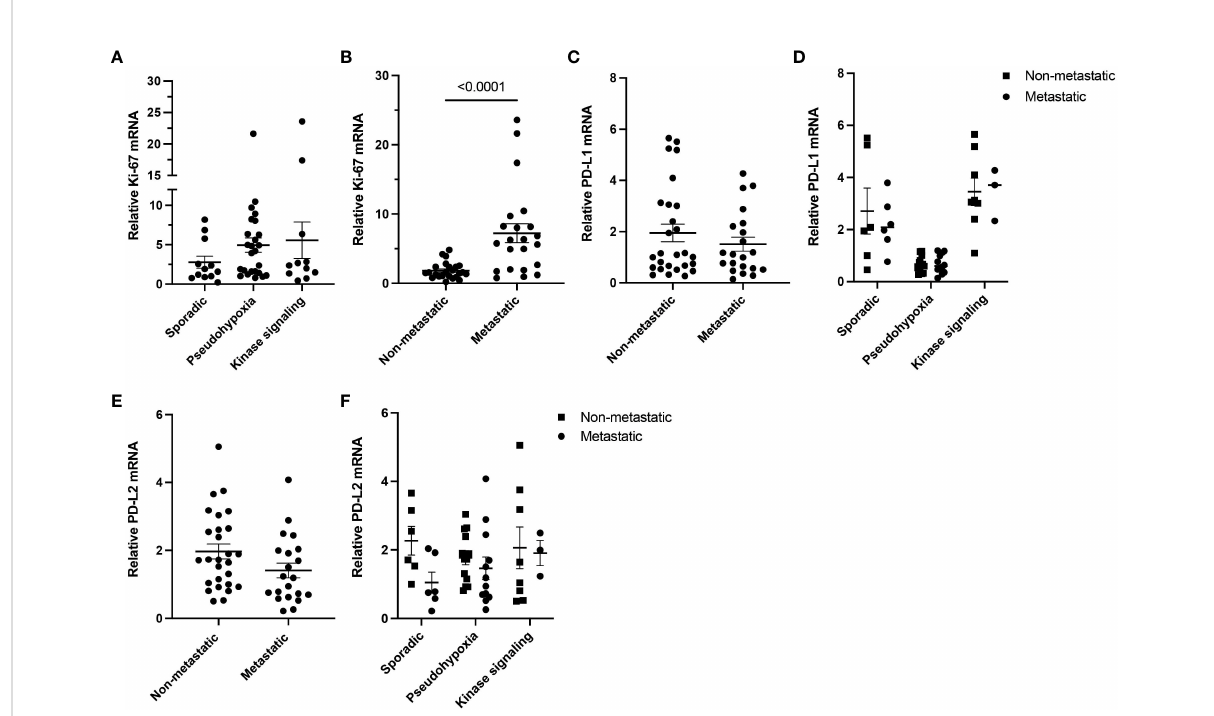
FIGURE 2 Ki-67 , PD-L1 , and PD-L2 expressions in metastatic and non-metastatic PPGLs. (A) Expression of Ki-67 measured in PPGL subtype clusters. (B) Expression of Ki-67 in metastatic and non-metastatic PPGLs. (C) Expression of PD-L1 in metastatic and non-metastatic PPGLs. (D) Expression of PD-L1 in metastatic and non-metastatic tumors in PPGL clusters. (E) Expression of PD-L2 in metastatic and non-metastatic PPGLs. (F) Expression of PD-L2 in metastatic and non-metastatic tumors in PPGL